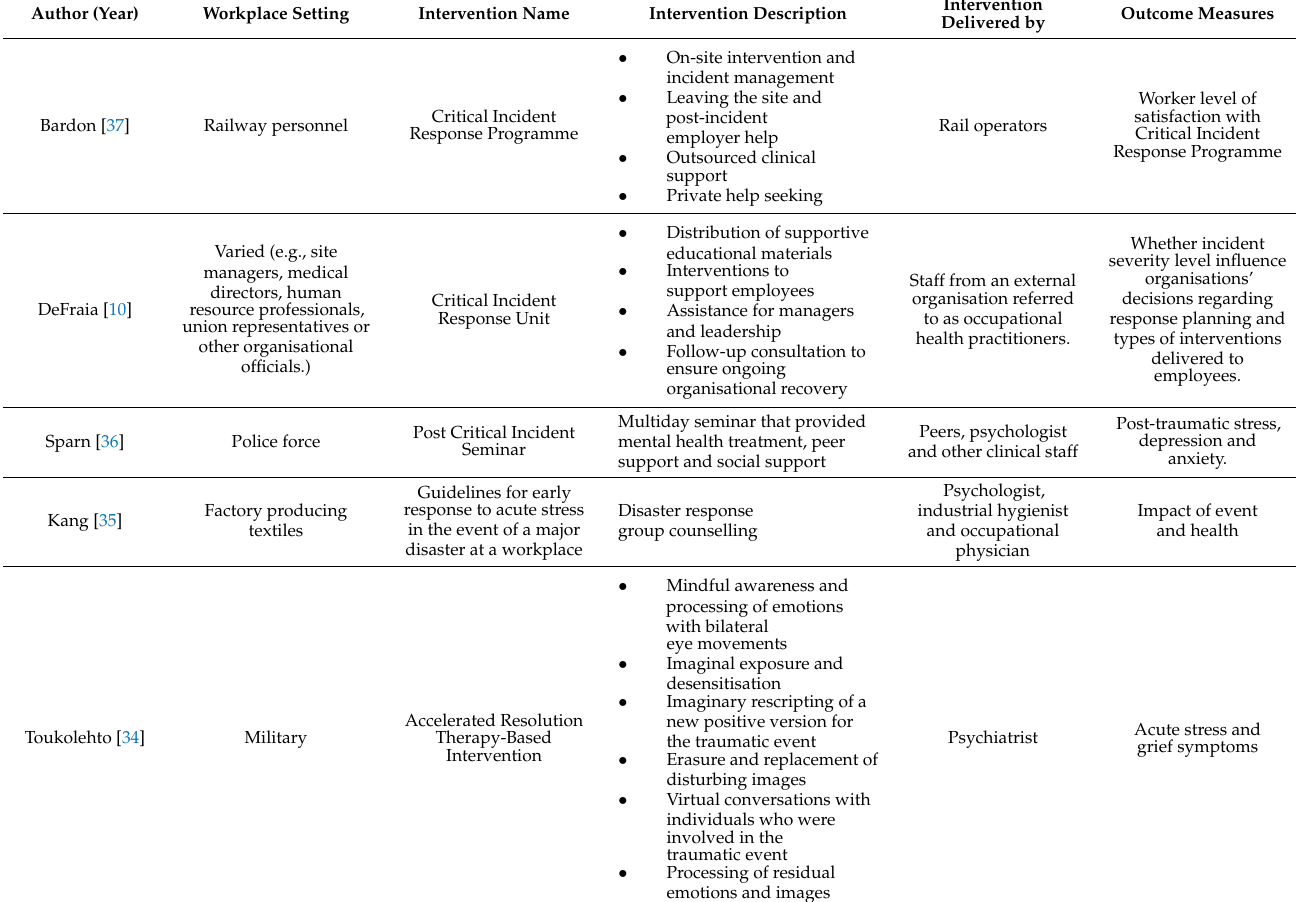
Table 2. Study workplace intervention